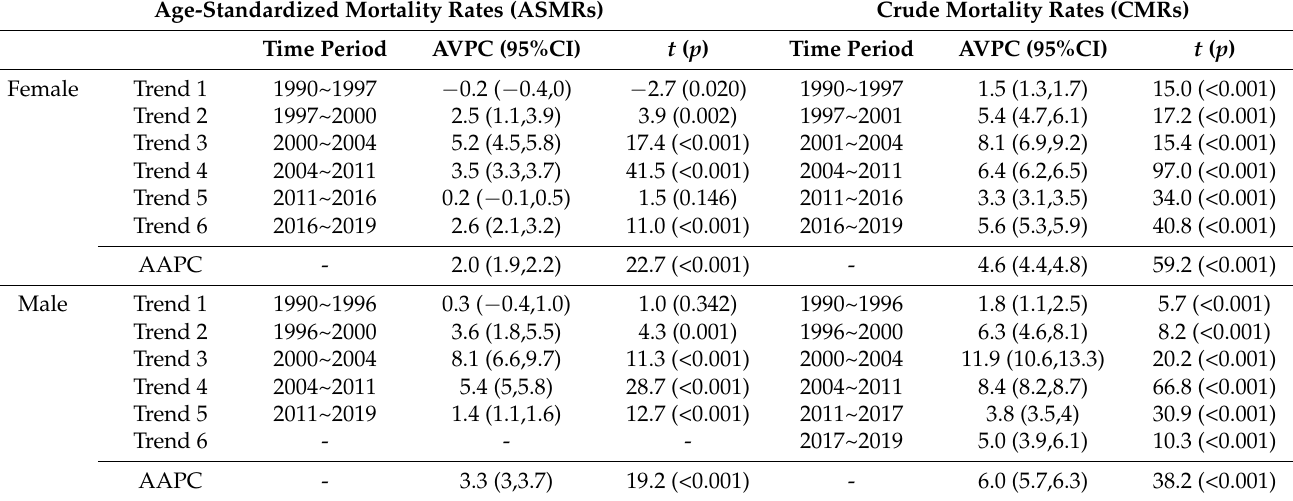
Table 1. Average and annual percent changes (AVPCs and AAPCs) of CRC mortality attributable to high PM intake.